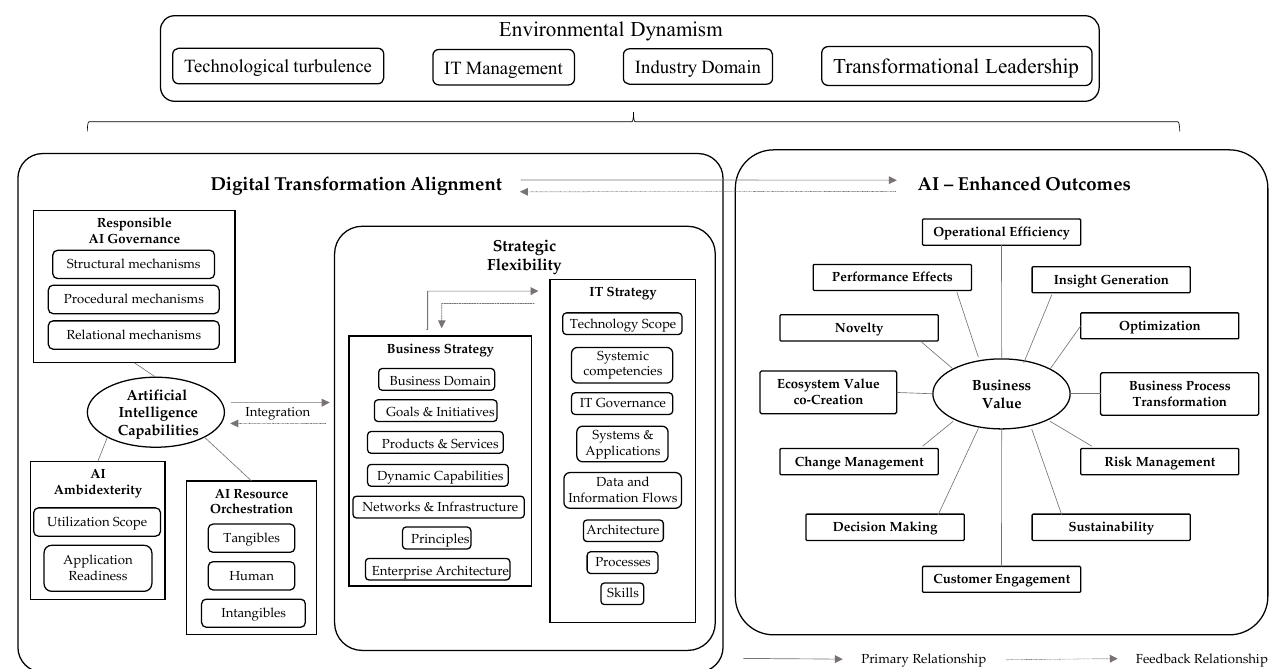
Figure 5. Conceptual framework . Source: Own elaboration.